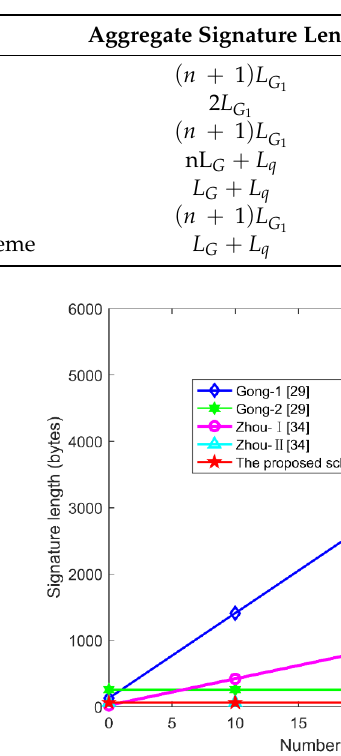
Table 6. The comparison of communication cost.